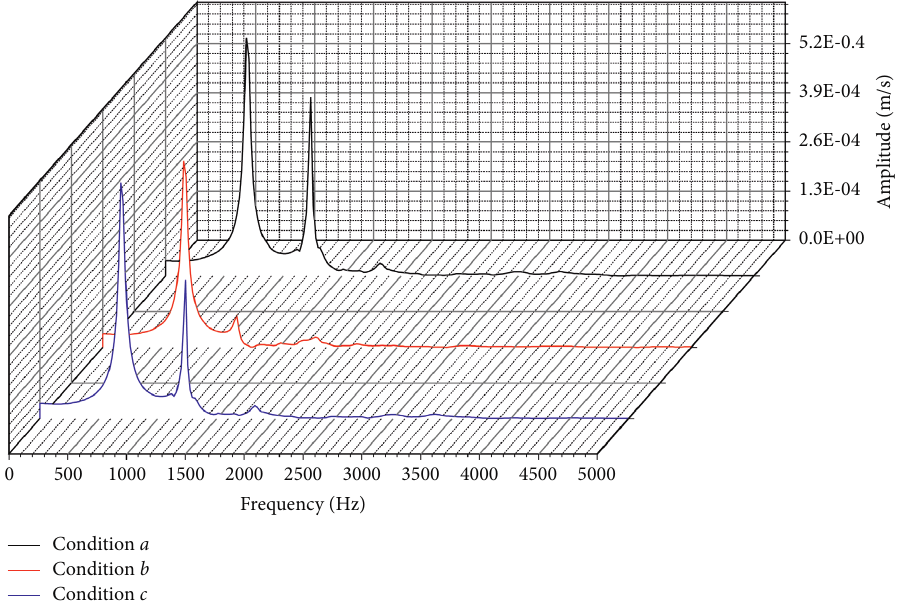
Figure 12: Spectrogram of defect area at different tap positions.